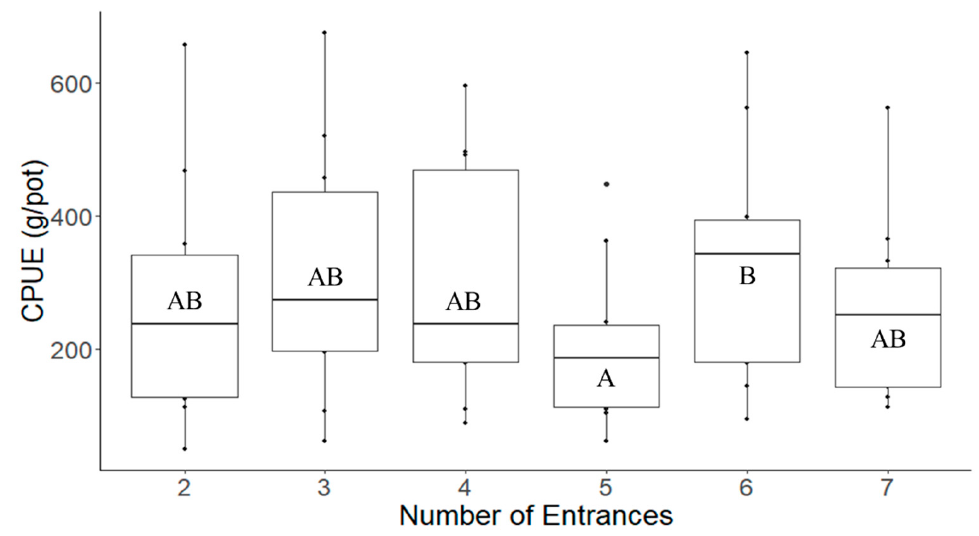
Figure 4. Catch per unit effort (g/trap) of crayfish in six different traps varying in the number of entrances. Horizontal line within each box represents the median. Lower and upper hinges of the boxes represent the first and third quartile, respectively. Lower and upper whiskers depict scores outside the interquartile range. Black dots correspond to the outliers.